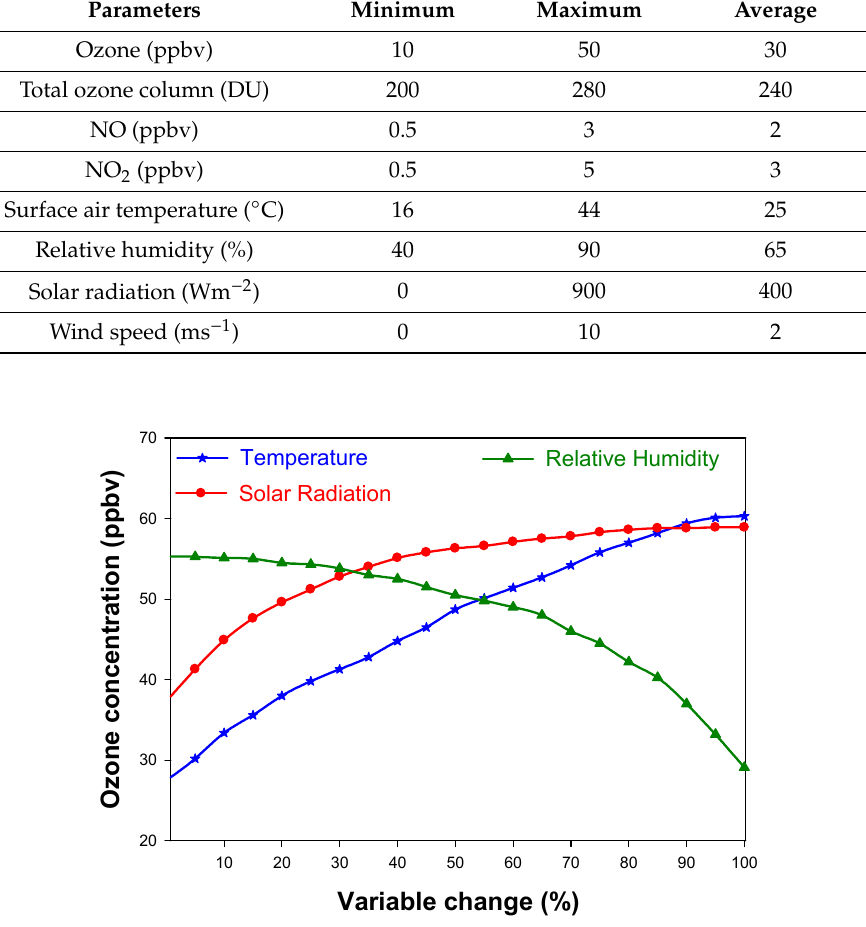
Figure 4. Neural network output for O 3 concentration with respect to the variation of temperature, solar radiation, and relative humidity.